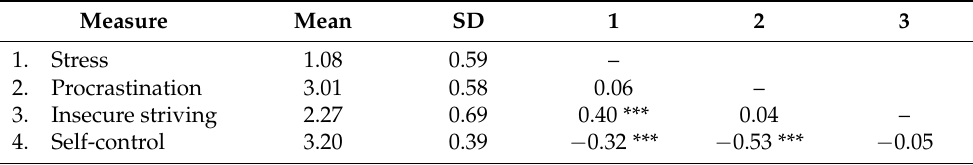
Table 2. Means, Standard Deviations and the Intercorrelations among Variables of the Study.